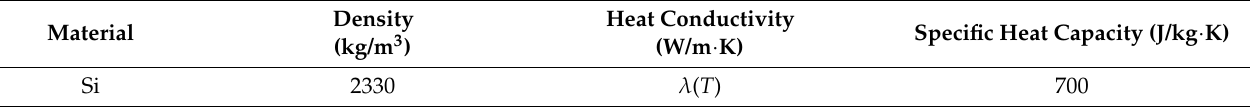
Table 2. Material parameters of the chip